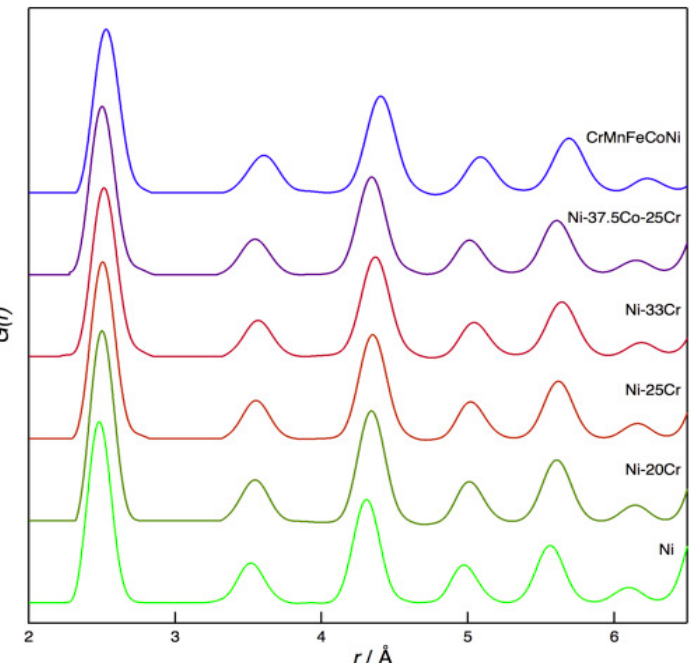
Figure 12. Normalized pair distribution function 3 for typical Ni-based alloys compared with the CrMnFeCoNi alloy based on the first six coordination shells [189].